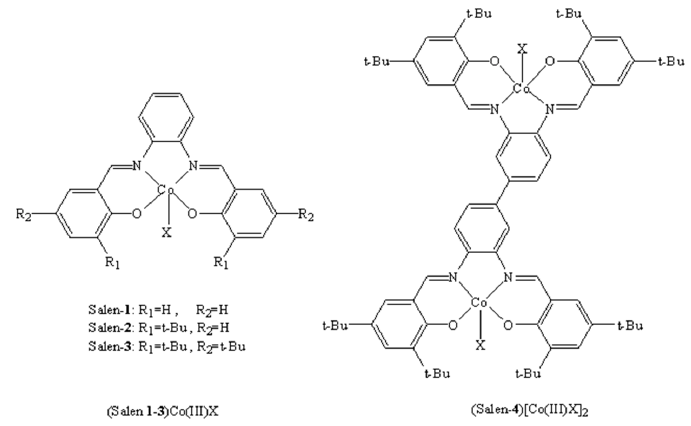
Figure 1. (Salen)Co(III)X catalyst for PO/CO 2 copolymerization (X = Cl, DNP, TFA).